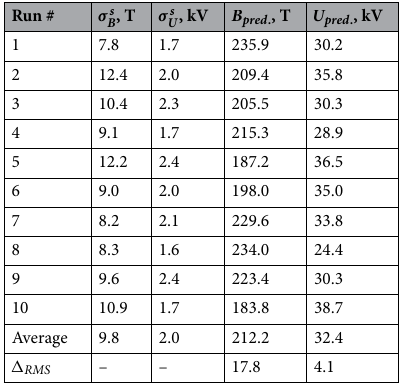
Table 1. Summary of the results obtained by the ANN in 10 training runs: root-mean-square errors σ s B and σ s U obtained using the synthetic data, and predicted values for the magnetic field at the coil center the electric potential of the target U pred . , obtained by passing the real experimental image through the trained CNN.